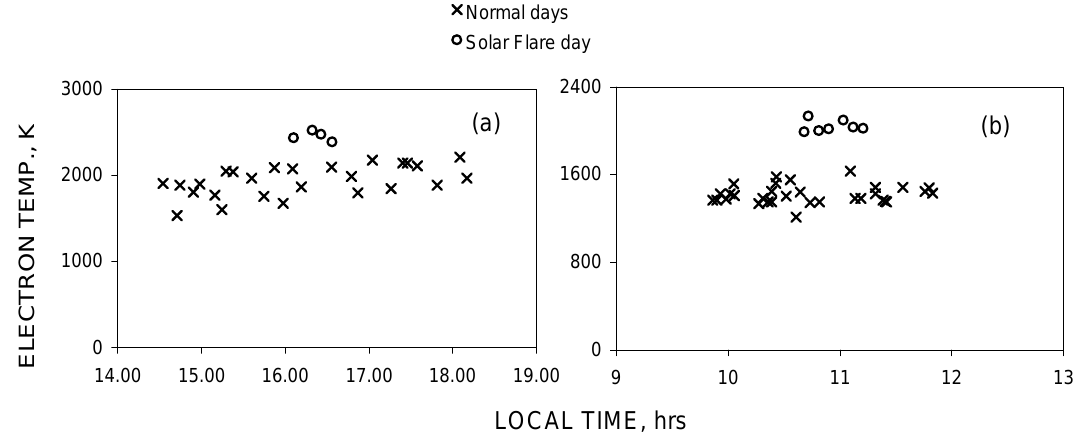
Fig. 3. Variation of electron temperature recorded by the SROSS-C2 satellite during solar flares and normal days at Panji.